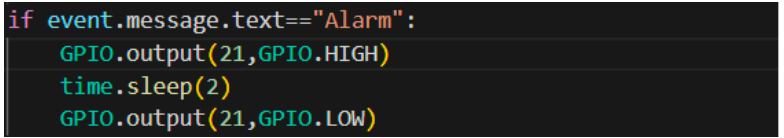
Figure 14. The code corresponds to the “Open Door” message.